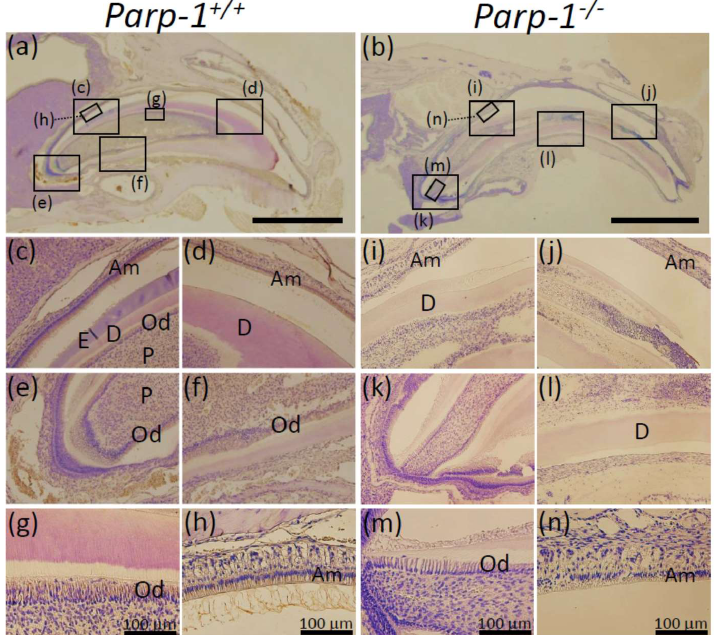
Figure 7. Immunohistochemical analysis of Parp-1 expression in aged Parp-1 +/+ and Parp-1 −/−